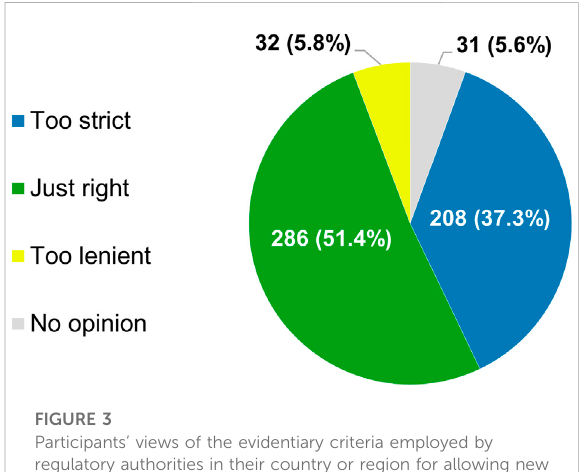
FIGURE 3 Participants ’ views of the evidentiary criteria employed by regulatory authorities in their country or region for allowing new anticancer treatments to enter the market. The percentages shown do not add up to exactly 100% due to